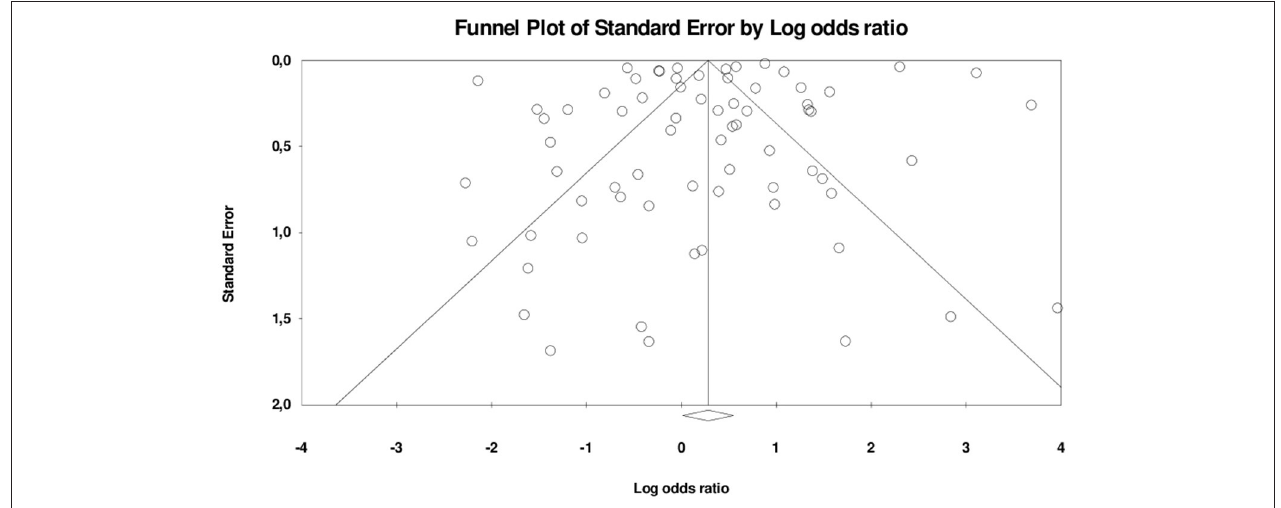
FIGURE 4 | Funnel plot RC 5 with adverse maternal